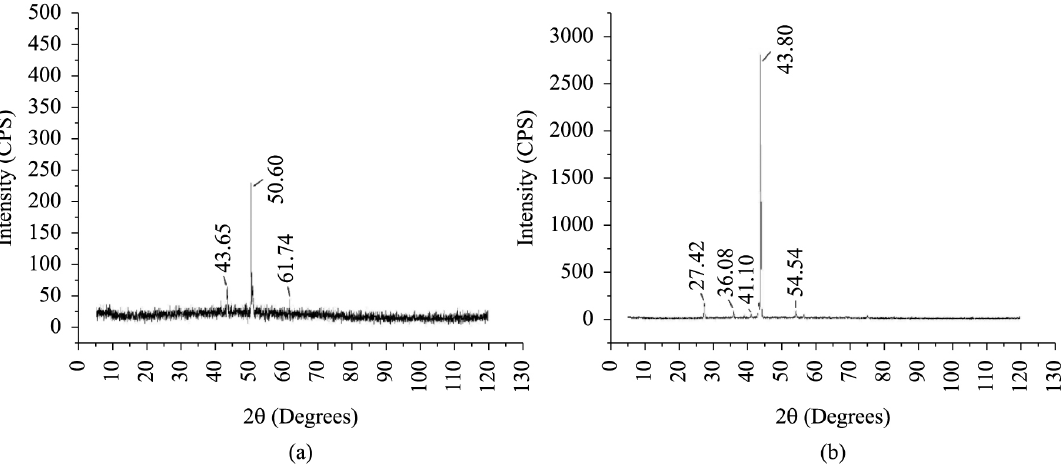
Figure 8. Diffractogram of (a) uncoated diamonds and (b) Ti-coated diamonds, after heat treatment during 180